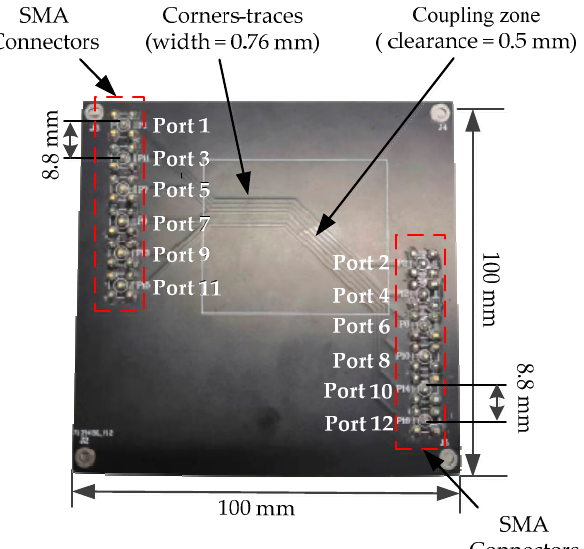
Figure 13. The multi-trace-validated structure.